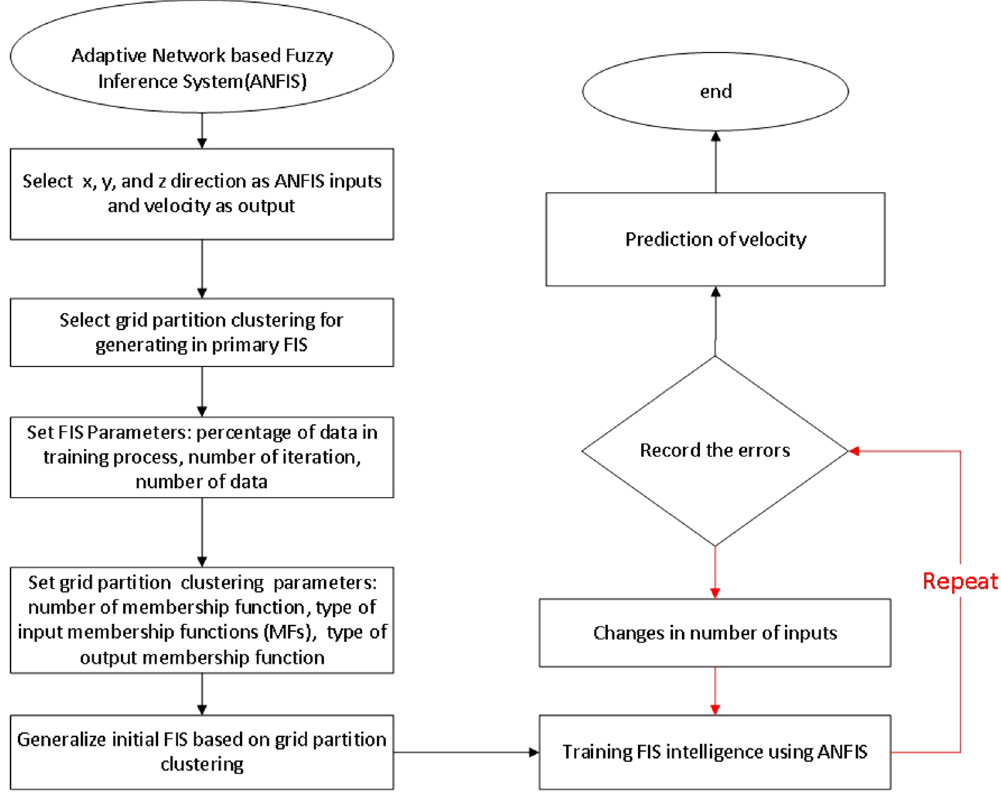
Figure 3. Flow chart for the model of ANFIS in predicting fluid characteristics in the bubble column